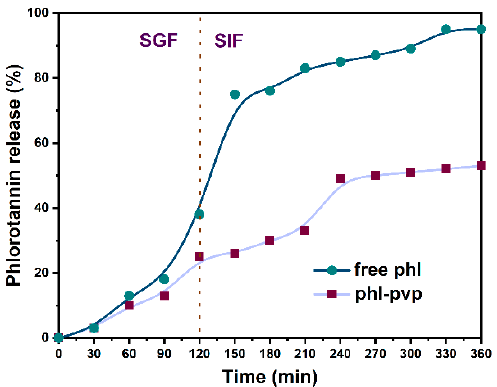
Figure 4. Release profile of free phlorotannin and PPNPS (1:8, w/w ) in simulated gastrointestinal fluids.